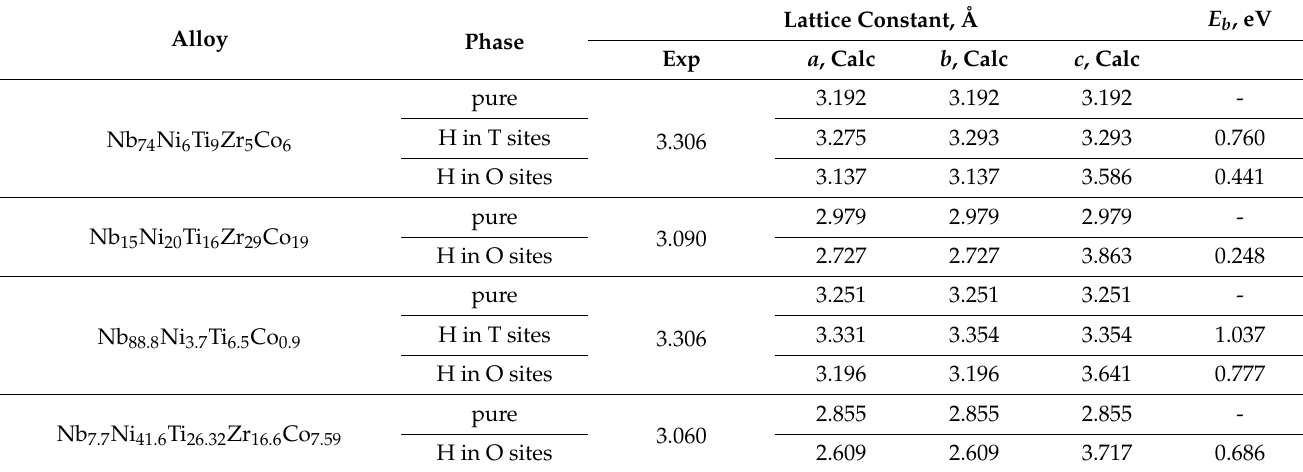
Table 2. Lattice parameters and binding energies, Eb, for the hydrogen atom. Alloy